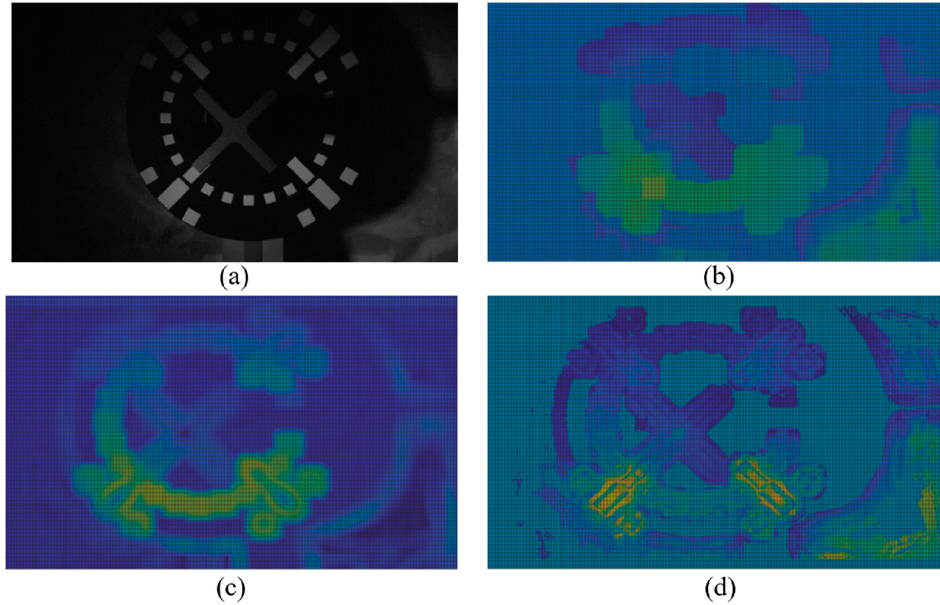
Figure 12. Binarization-threshold heatmap: ( a ) original image; ( b ) Bernsen method; ( c ) Sauvola method; ( d ) proposed method.